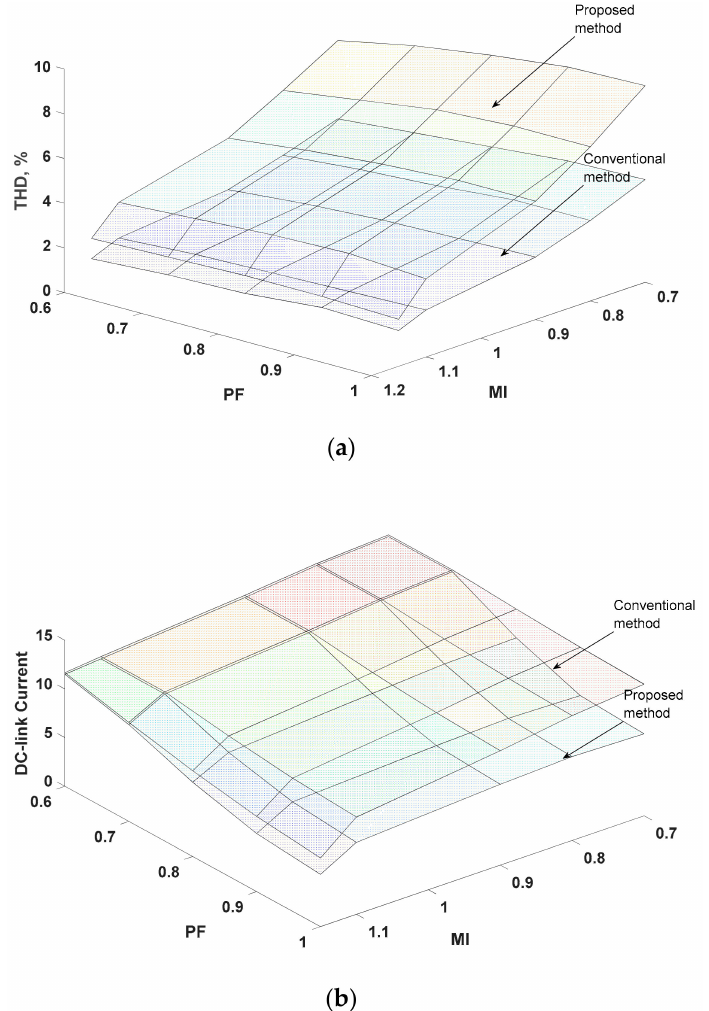
Figure 10. Simulation results for different power factor (PF) and modulation index (MI): ( a ) Total Harmonic Disturbance (THD) of the ac-current; ( b ) DC-link ripple